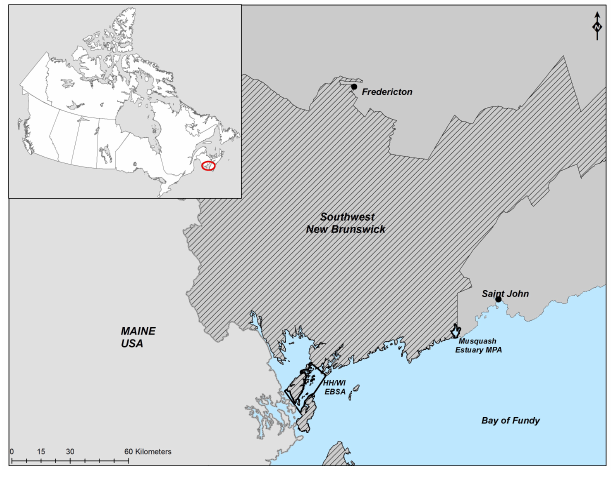
Fig. 2 . Map of case study region in Southwest New